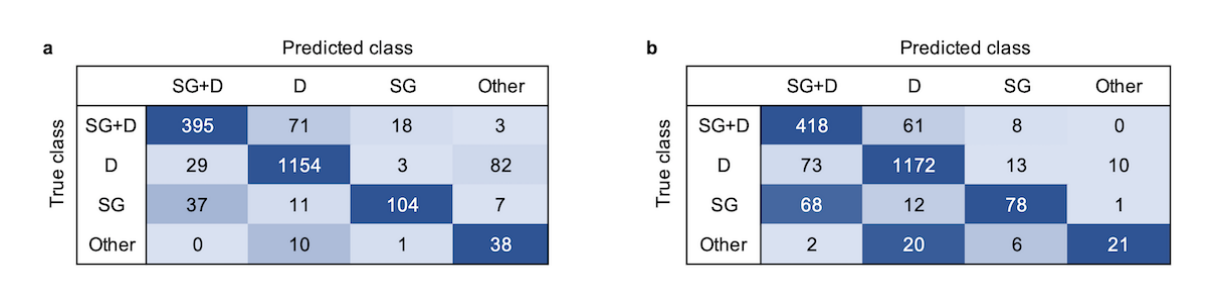
Figure 6. (a) Classifier and (b) human coder confusion matrices for fully inclusive layout. D: Dialogue; SG: Screen Gaze; SG+D: Screen Gaze +